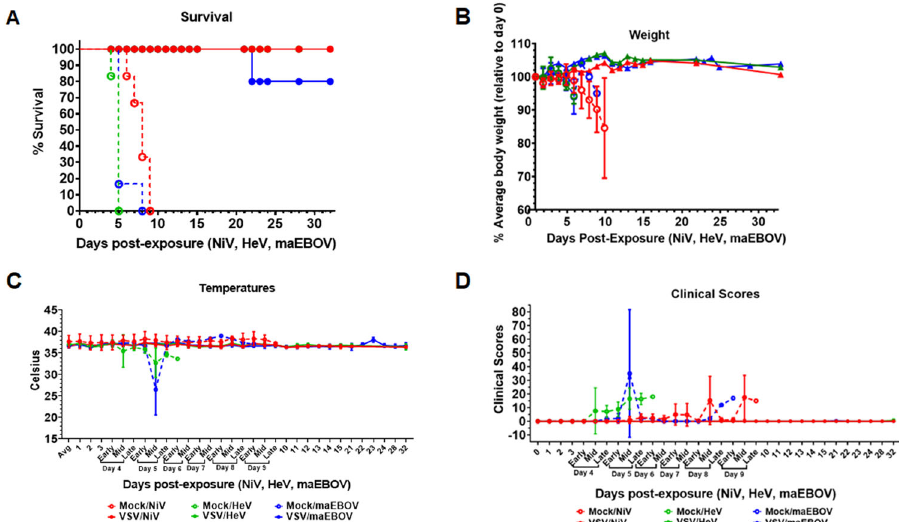
Fig. 9 Analysis of hamster survival, weight, and temperatures during the course of challenge experiments. A Percent survival of test- vaccinated vs. mock-vaccinated hamsters, following challenge with live NiV, HeV, or maEBOV. Hamsters vaccinated with the test vaccine survived challenge with all the three virulent viruses except that one hamster died from a lymphoma (unrelated cause). Those vaccinated with mock VSV virions were euthanized at critical control points after signs of disease. B Weight records for the test vs. mock vaccinated hamsters groups. Hamsters in the test vaccine group showed minimal variation on weight during the course of experiments while those in the mock- vaccinated groups registered signi fi cant weight loss prior to euthanasia. C Body temperature records for the mock vs. test-vaccinated groups. Hamsters test-vaccinated showed minimal variation in body temperatures while the variation was marked for the mock groups. D Clinical scores for the multivalent pseudotyped VSV vaccinated hamsters compared the mock-treated group. Clinical scores were based on a 15-point scale that includes scoring appearance, respiratory signs, mobility, temperature, and neurological signs such as paralysis, seizures, and appearing moribund. Additive scores of 15 or greater required immediate consultation with the veterinarian to determine animal disposition. There was marked deviation of clinical scores between test and mock vaccinated groups. Solid lines represent test-vaccinated animals, while dashed lines represent mock-vaccinated animals.